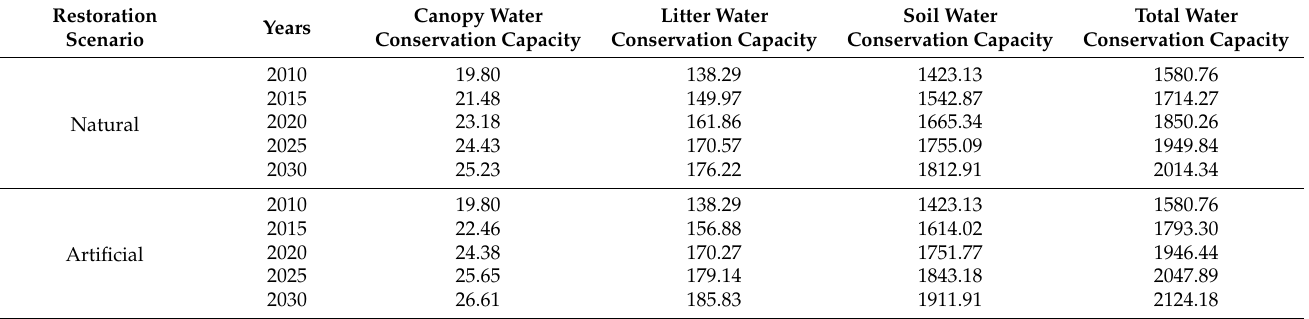
Table 5. Forest water conservation capacity under different forest restoration scenarios (t/hm 2 ).